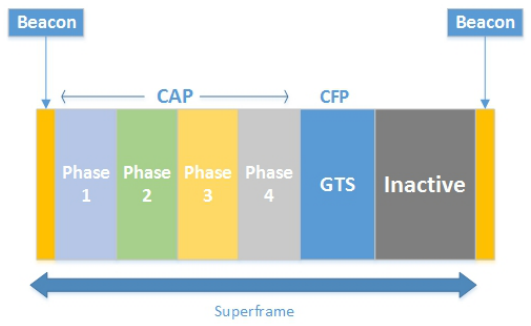
Figure 2. PA-MAC: priority adaptive MAC superframe structure [8].